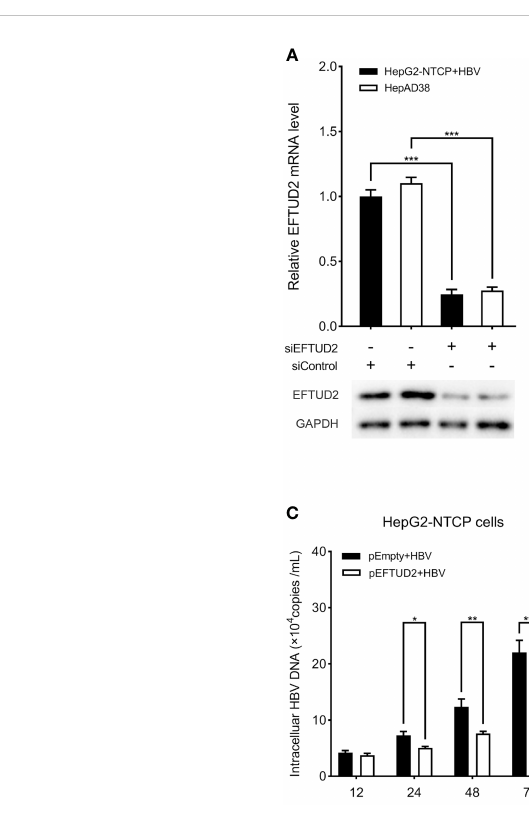
FIGURE 1 EFTUD2 had an anti-HBV effect in vitro . (A) The ef fi cacy of the knockdown of EFTUD2 was determined by qPCR and Western blot analyses in HepAD38 cells and HepG2-NTCP cells. (B) The knockdown of EFTUD2 improved the HBV DNA levels. (C) EFTUD2 overexpression inhibited HBV replication at 12, 24, 48, 72 h postinfection. (D) Real-time PCR and Western blot analyses showed that EFTUD2 was downregulated in HepG2-NTCP and HepG2 cells treated with HBV particles at 48 h. *, P < 0.05; **, P < 0.01; ***, P <